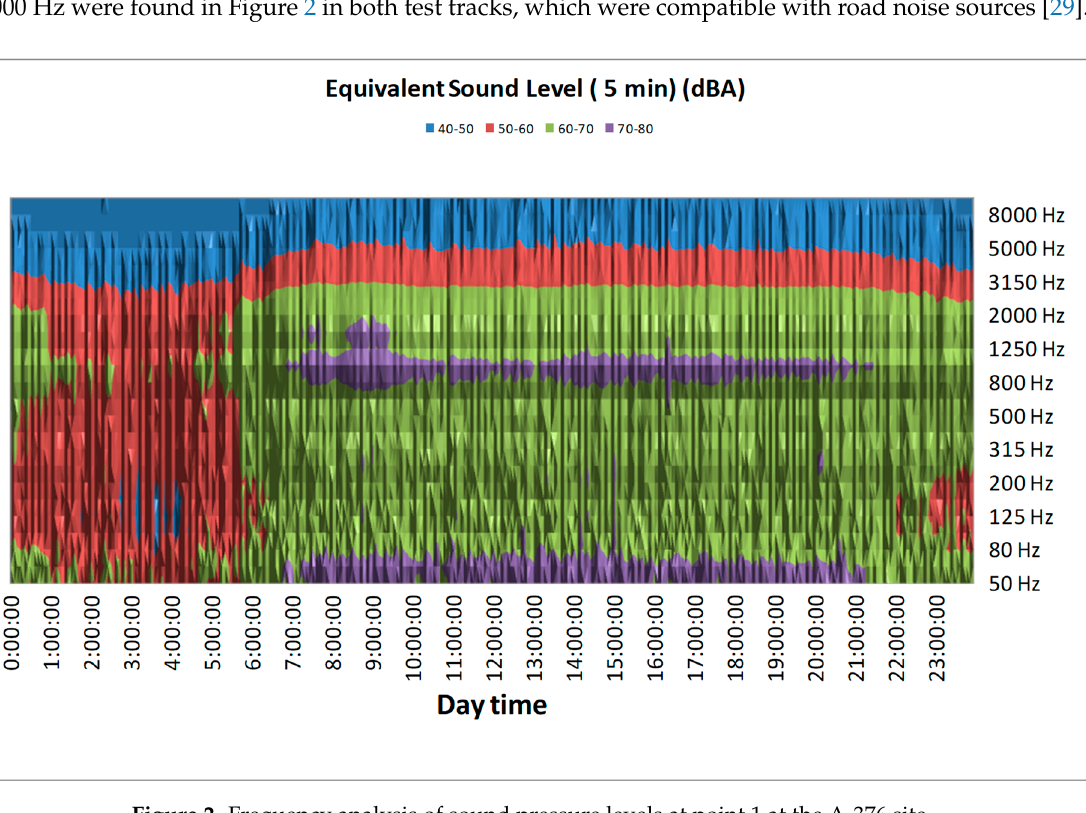
Figure 2. Frequency analysis of sound pressure levels at point 1 at the A-376 site.